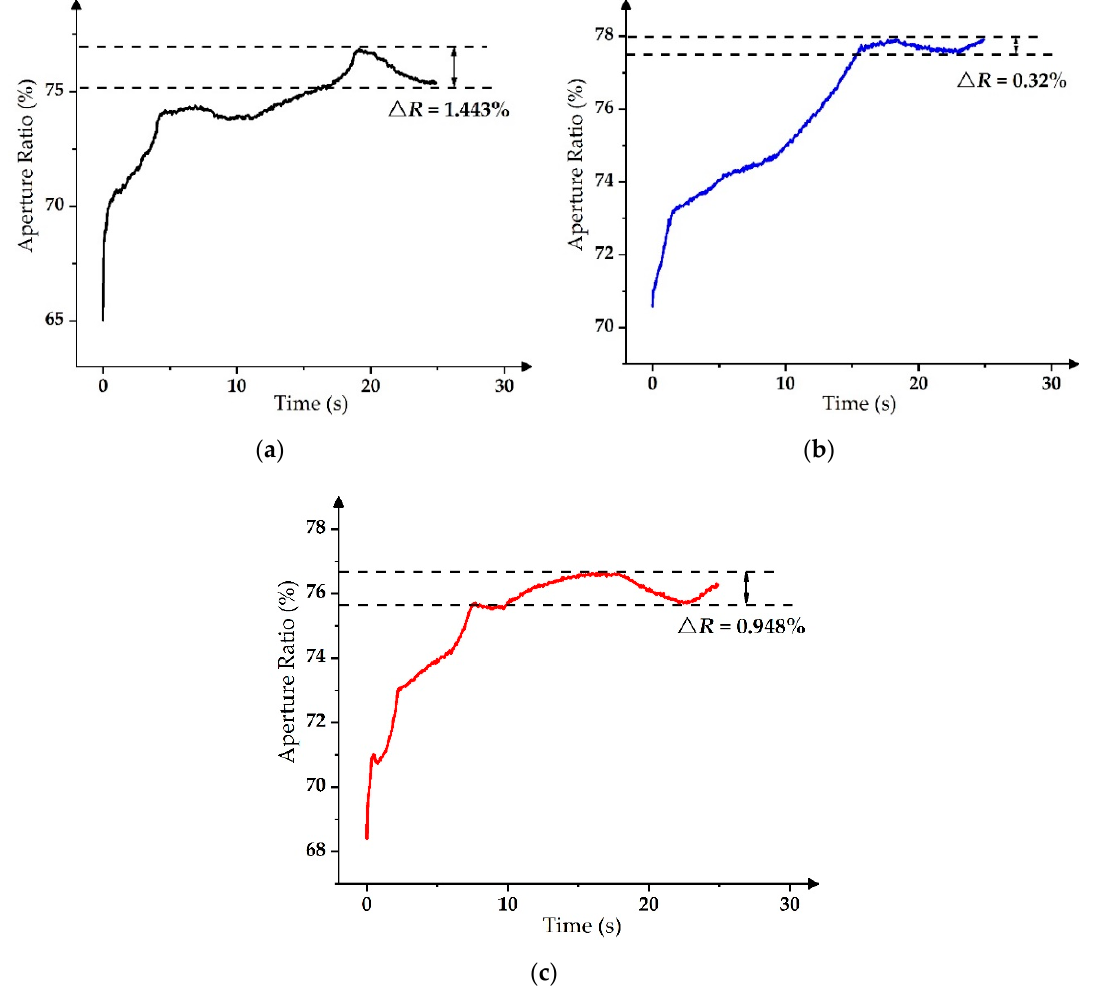
Figure 10. Aperture ratio response of different driving waveforms. ( a ) PWM with a duty cycle of 90% [14,30]. ( b ) Slope-driving waveform with K = 10 V/ms [17,31]. ( c ) Exponential function with τ = 2 ms.